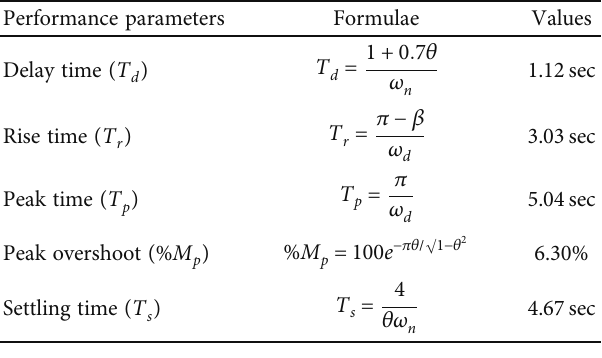
Figure 12: Output voltage V Table 8: Evaluation of performance parameters of the output voltage of the open loop control of MSC.